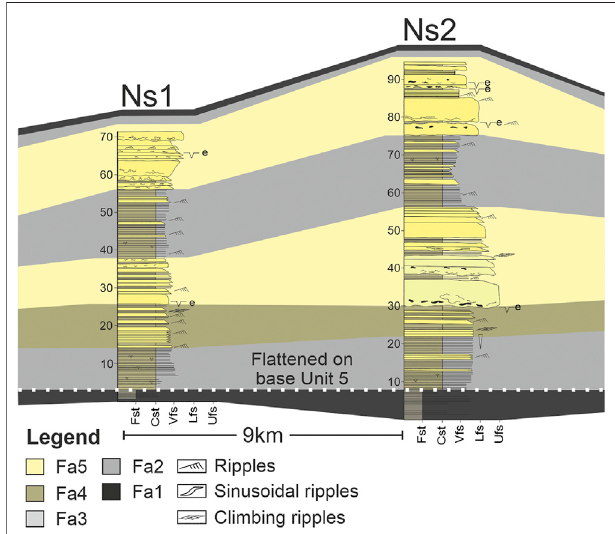
FIGURE 10 | Correlation between cores NS1 and NS2 with interpreted sedimentary facies indicated. The regional extent of the two sandstone packages is